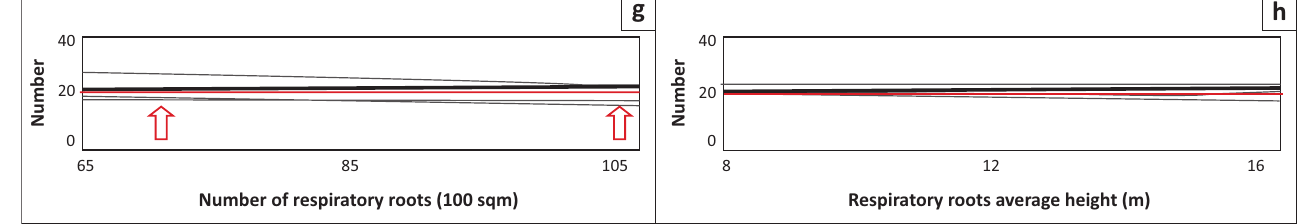
Red arrows = higher precision of uncertainty. FIGURE 8 (Continues...): Qurum Island demographic features sensitivity analysis (a) Density (100 m 2 ); (b) Cover ( % ); (c) Tree height (m); (d) Crown diameter (m); (e) Number of dead trees (100 m 2 ); (f) Number of seedlings (100 m 2 ); (g) Number of respiratory roots (100 m 2 ) and (h) Average height of respiratory roots (m).